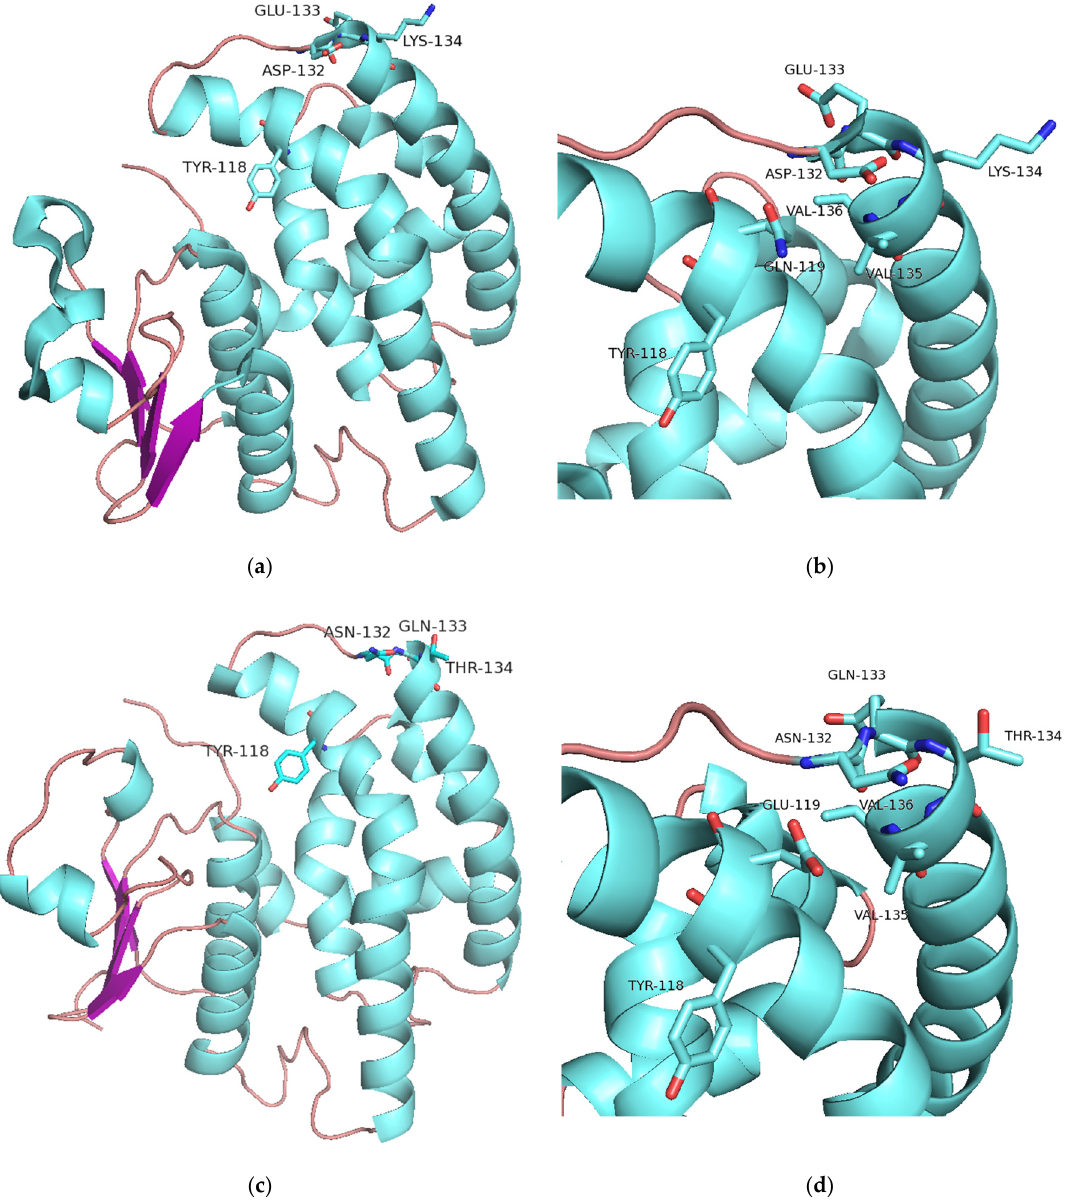
Figure 12. ( a ) Ribbon representation of the Am GSTF monomer, showing the motif Asp-Glu-Lys in relation to Tyr118. ( b ) Amino acid residues in Am GSTF that contribute towards inhibition sensitivity by butachlor. ( c ) Ribbon representation of the monomer of sh155 variant, showing the Asn-Gln-Thr motif. ( d ) Amino acid residues in sh155 variant that contribute towards inhibition sensitivity by butachlor. The figures were created by PyMol [61].